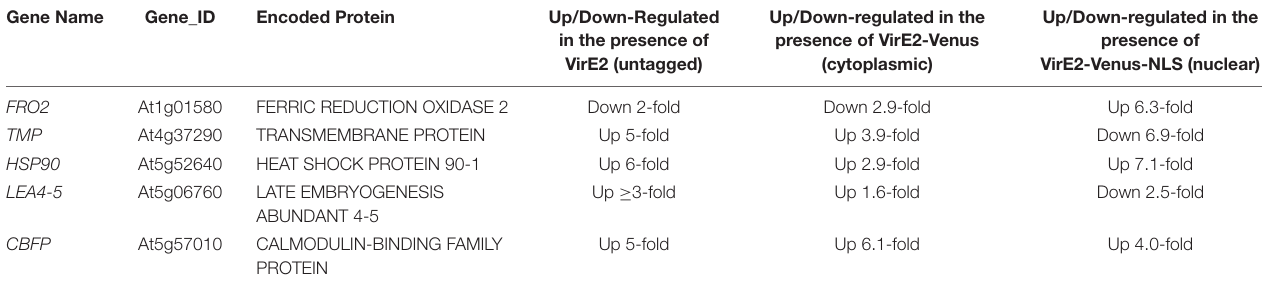
TABLE 3 | VirE2 subcellular localization impacts changes in plant gene expression.